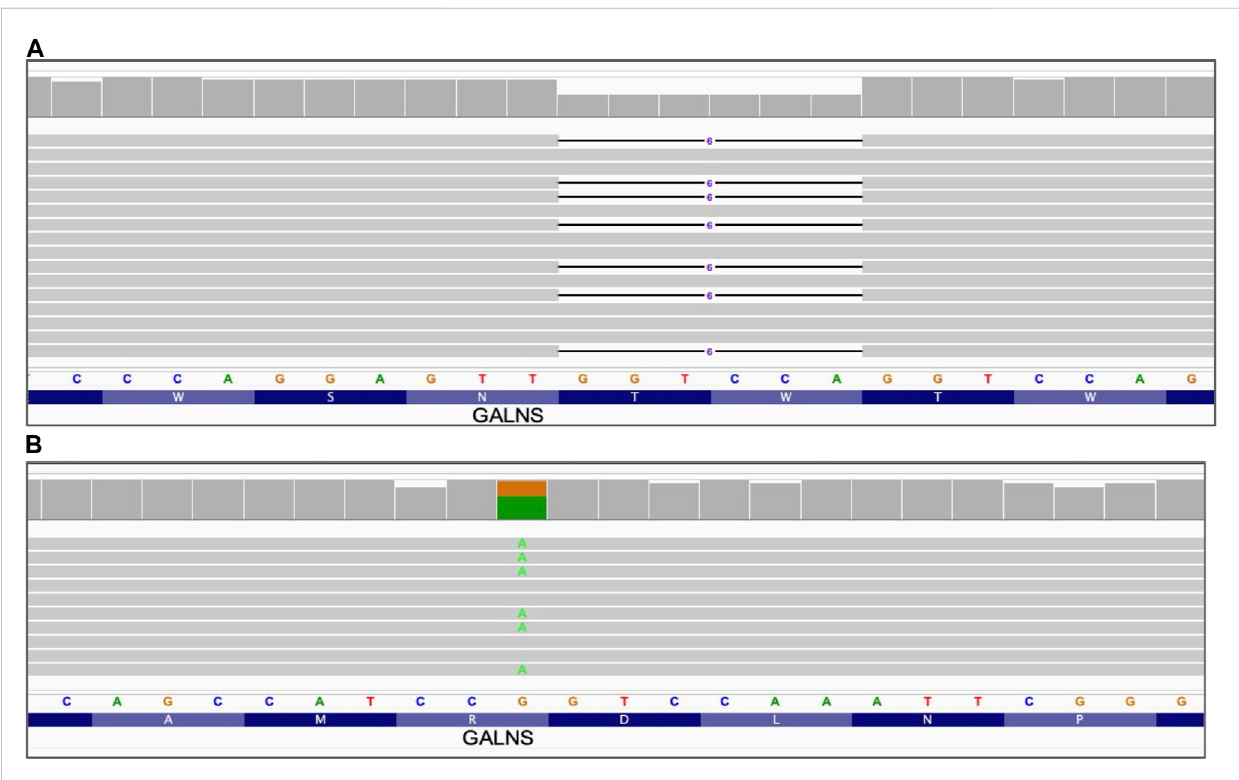
FIGURE 1 Small sequence changes. Alignment view of the long read WGS of sample NA01361, GALNS gene. Each thick gray horizontal line represents a separate read. Narrow horizontal lines with numbers represent deletions of the indicated length (in base pairs). Top of each panel represents a local